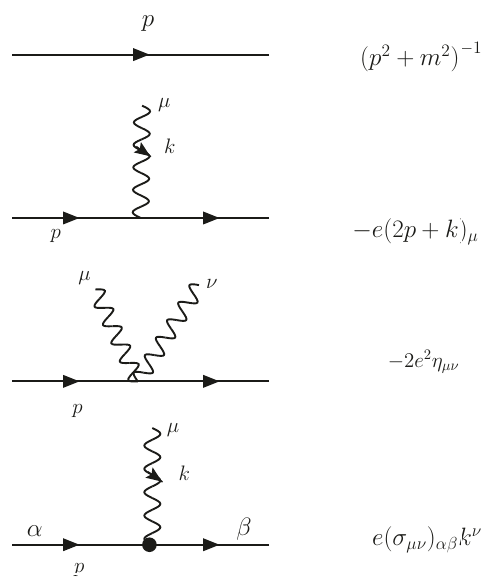
Figure 1 . Feynman rules for spinor QED in the second-order